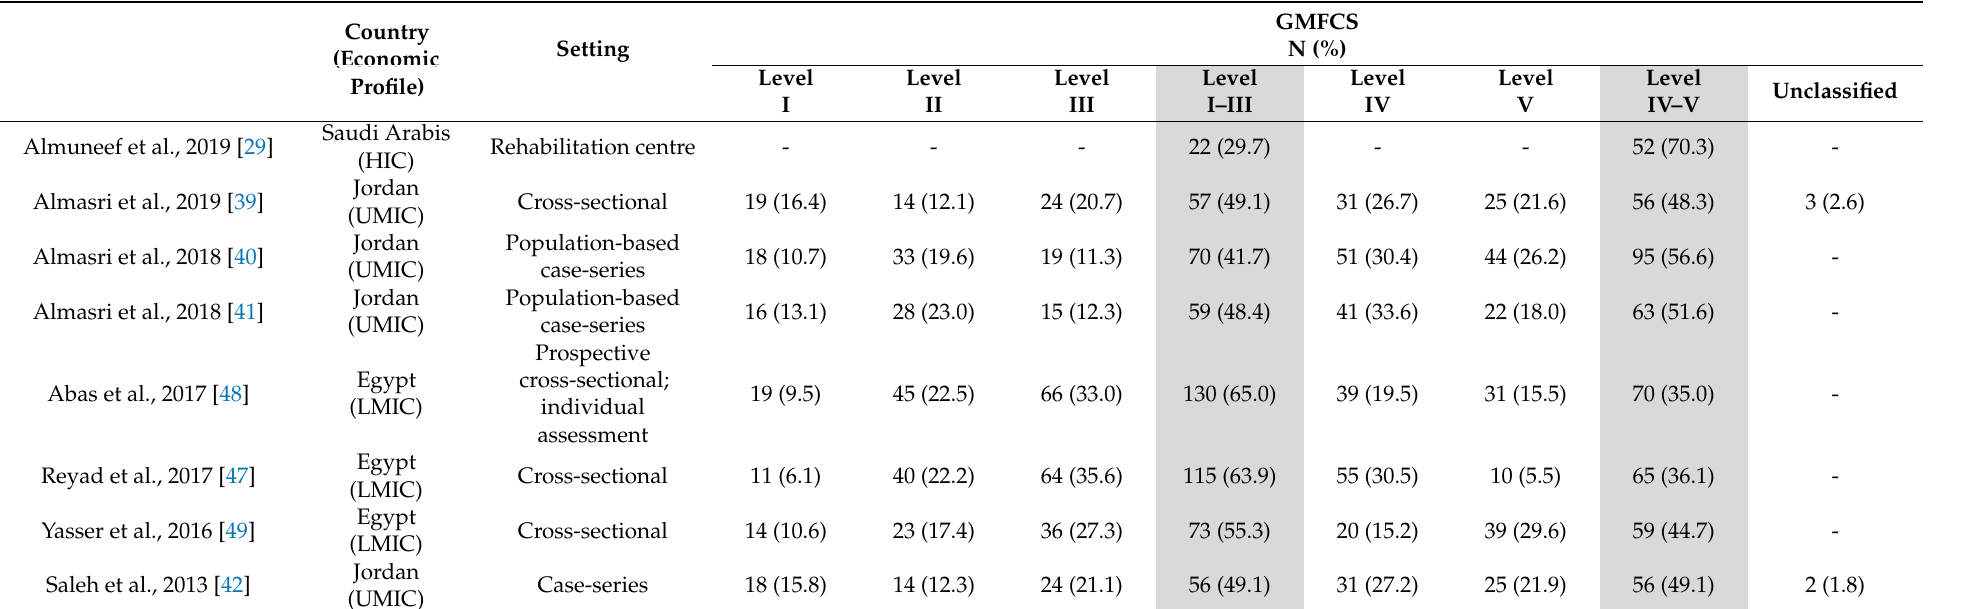
Table 4. Publications that reported CP cases according to Gross Motor Function Classification